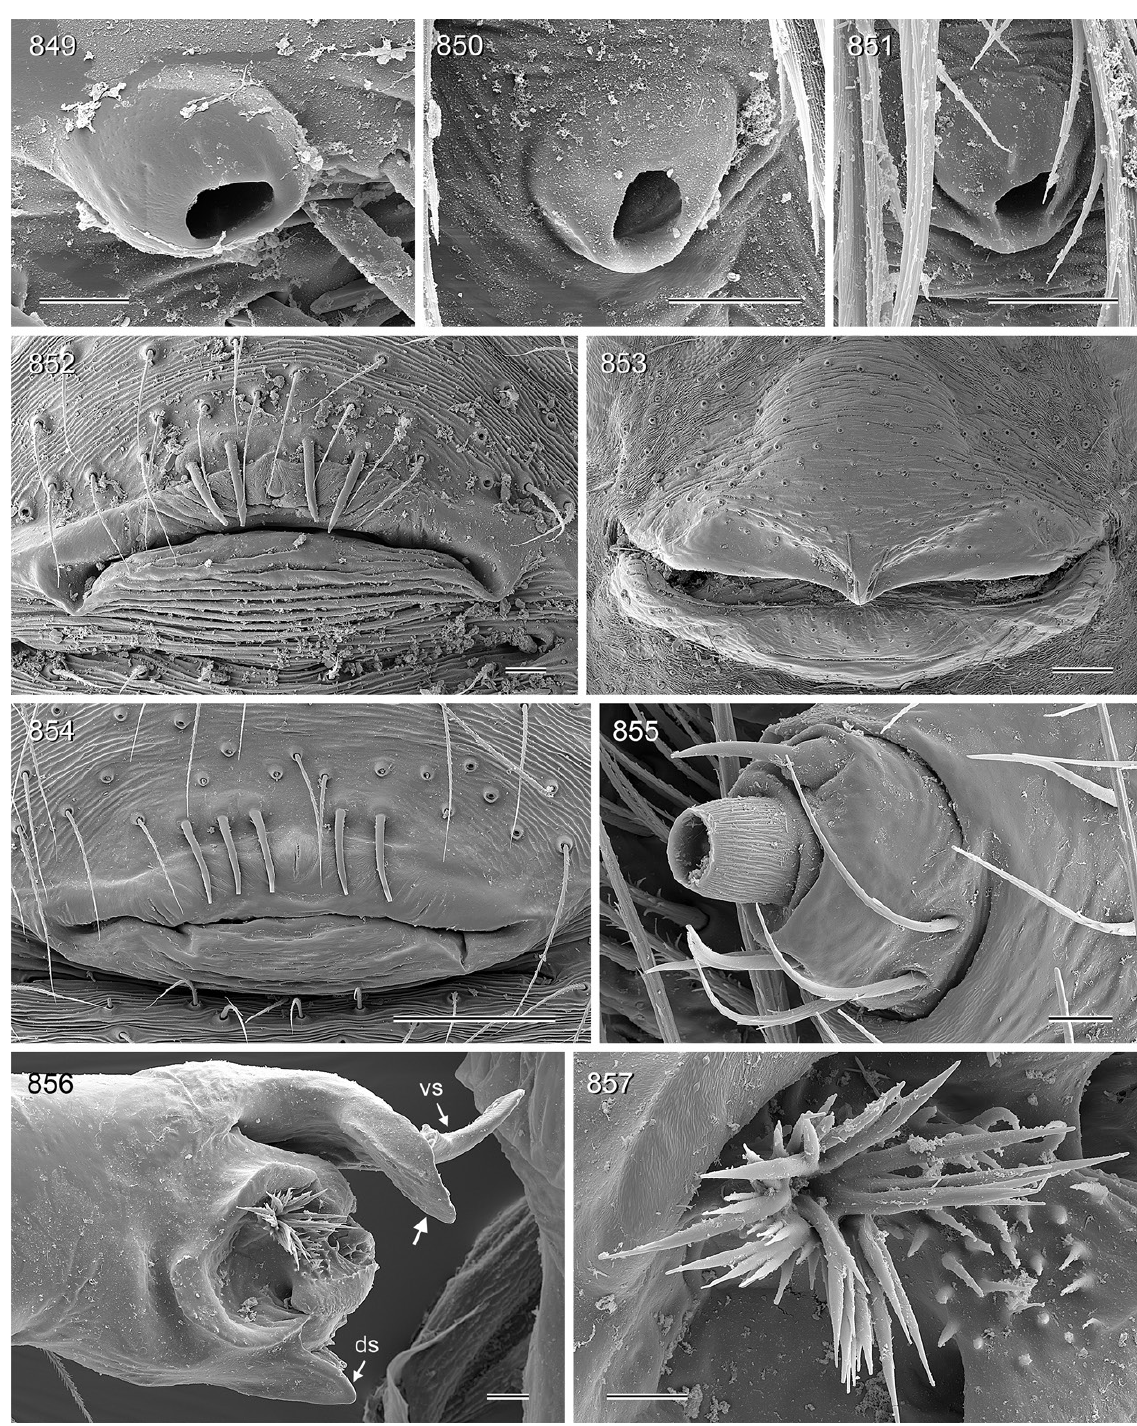
arrow: branch of ventral sclerite. 857 . Detail of preceding figure. Abbreviations: ds = dorsal sclerite; vs = ventral sclerite. Scale bars: 849–851, 855, 857 = 10 µm; 852, 856 = 20 µm; 853–854 = 100